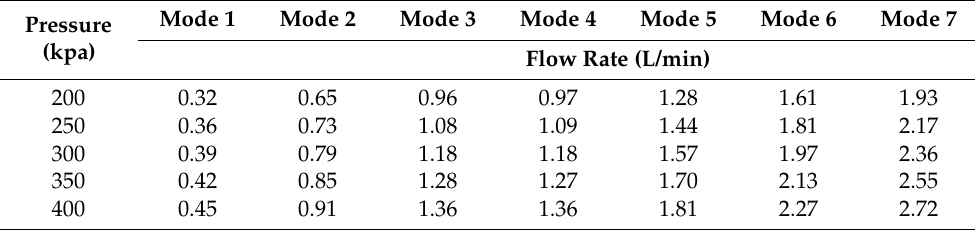
Table 3. Theoretical parameters of different types of spraying methods.